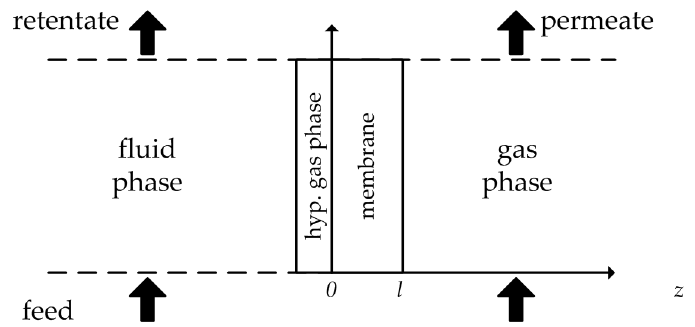
Figure 1. Hypothetical gas phase between feed solution and membrane. Illustration adapted from [6].